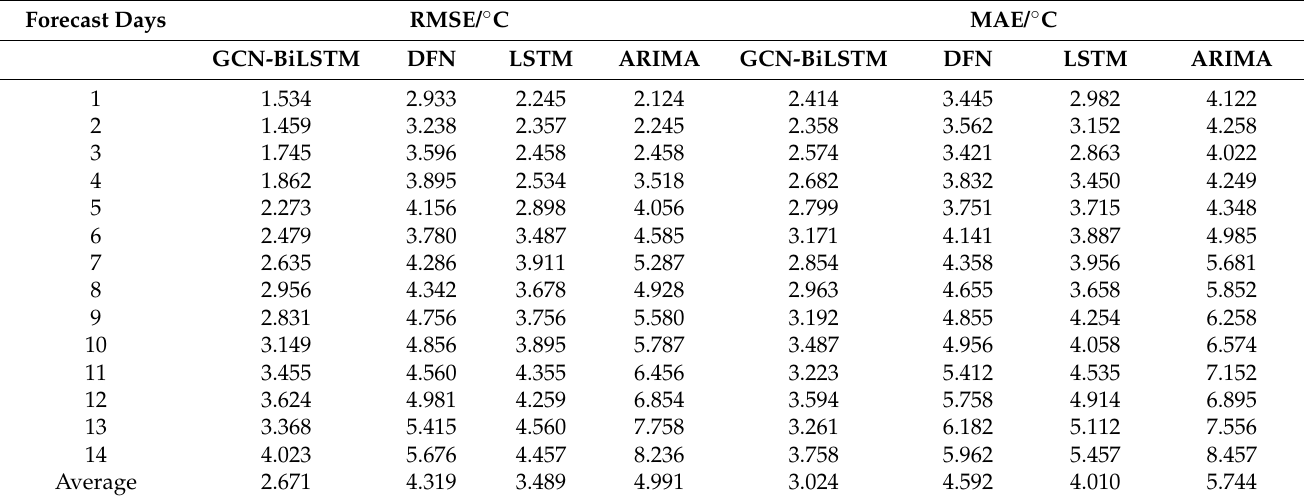
Table 7. Experimental results of temperature prediction for the next 14 days.